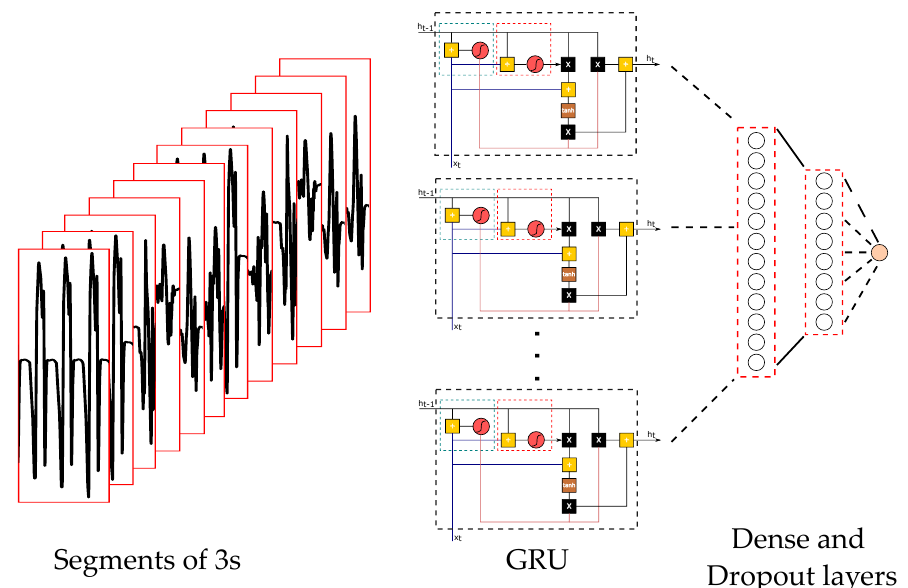
Figure 8. Architecture of the GRU implemented in this